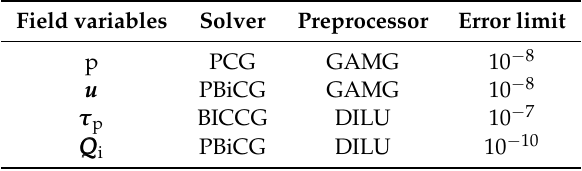
Table 2. The basic configuration of linear equations solver.